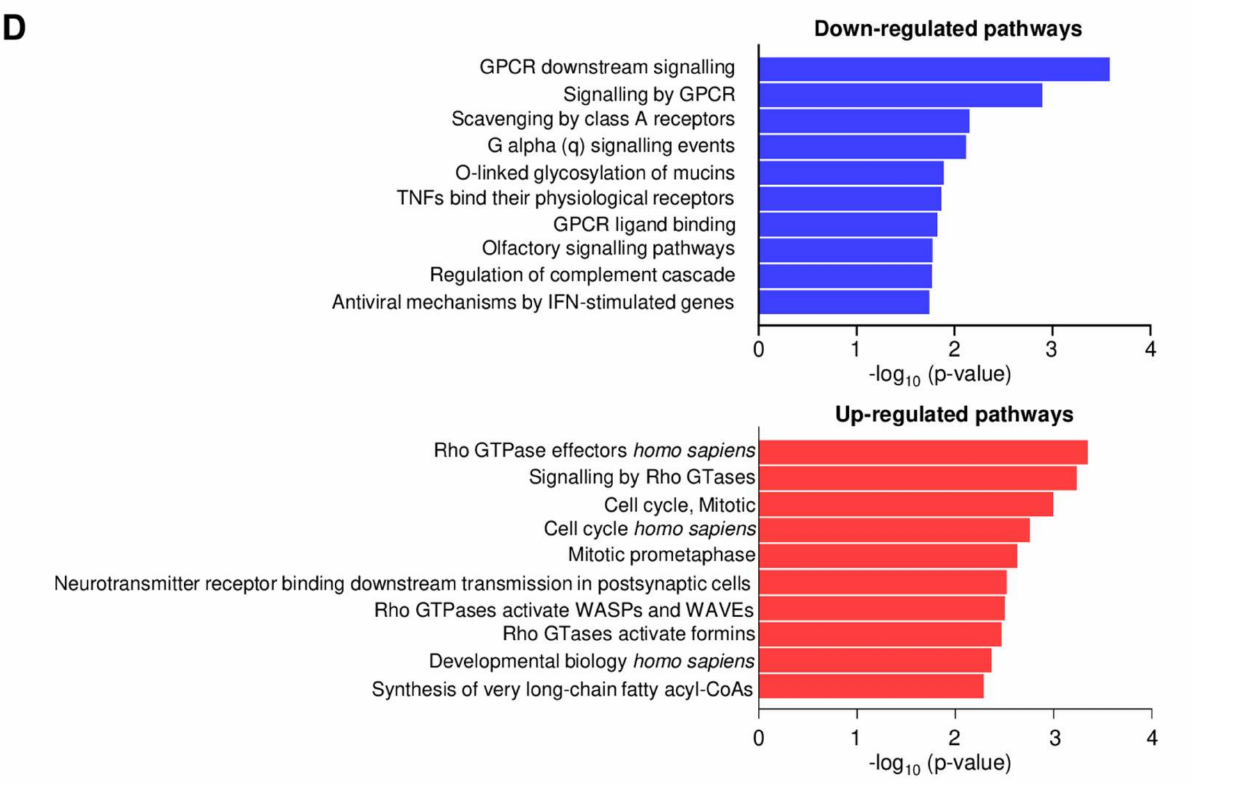
Figure 5. Genome-wide expression analyses of AC-265447 and CIN-treated neuroblastoma xenografts reveal biased signaling by both calcimimetics. ( A ) Hierarchical clustering comparing gene expression pattern in LA-N-1 xenografts exposed to AC-265347 or CIN. These were the eight tumors exposed for the longest time to the drugs. ( B ) Venn diagrams for AC-265347 and CIN differential expressed genes in LA-N-1 xenografts exposed to these calcimimetics. Each diagram contains the number of genes represented. Common genes are represented in dark shading. ( C ) Relative expression of NNAT and BNC2 mRNA in AC-265347 and CIN-treated LA-N-1 tumors. Statistical significance was calculated using two-tailed Mann–Whitney U test to compare all AC-265347 and CIN xenografts. * p < 0.05. ( D ) Most significantly enriched terms in LA-N-1 xenografts exposed to calcimimetics. Blue color indicates downregulated and red upregulated gene